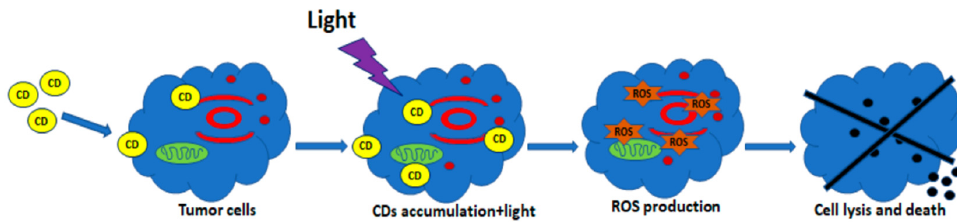
Figure 13. Schematic diagram of PDT. C-DOTs (CDs) penetrate the cell membrane and accumulate in the cytosol. Light irradiation actives and induces the production of ROS. Reproduced from Ref. [116] with permission from MPDI. Copyright 2021